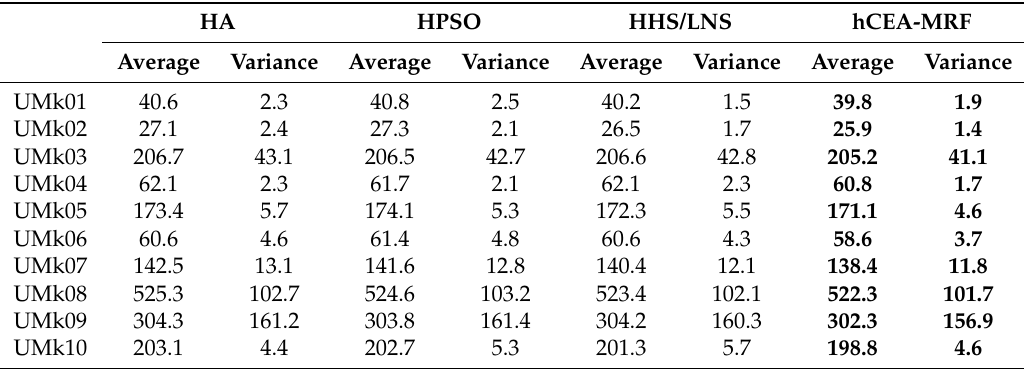
Table 4. The performance compared with the state-of-the-art for the generated instances by uniform distribution.